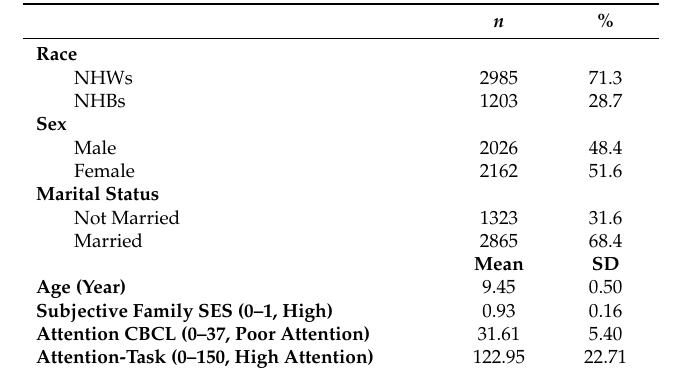
Table 1. Socio-demographic data overall ( n = 4188).